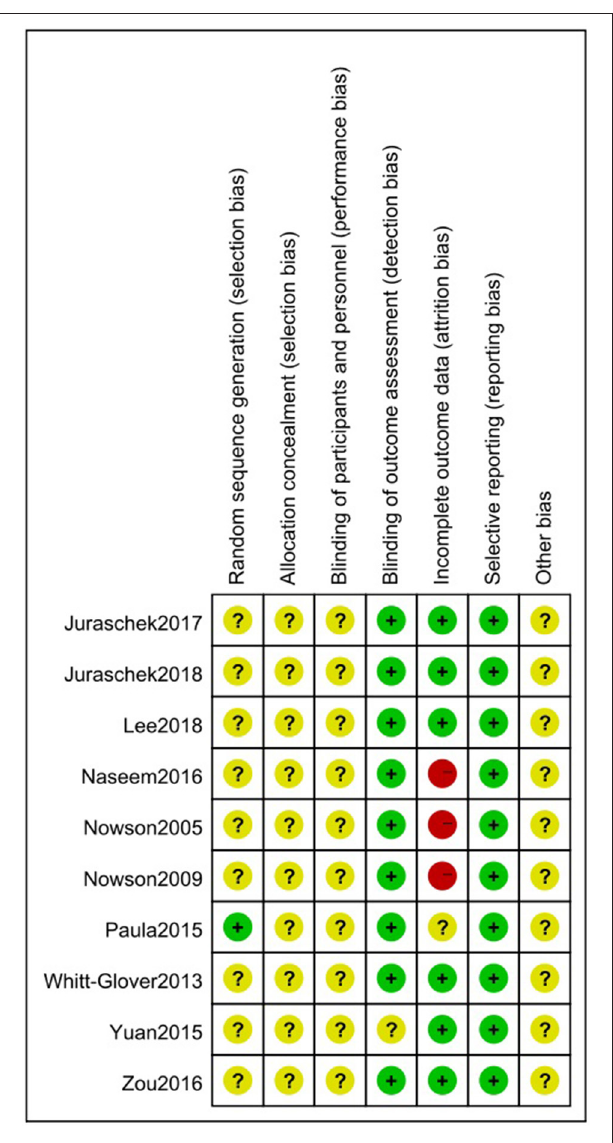
FIGURE 2 | Risk of bias summary for eligible randomized controlled trials using the Cochrane risk-of-bias tool. The symbol “ + ” represents a low risk of bias, the symbol “–” represents a high risk of bias, and the symbol “?” represents an unclear risk of bias.